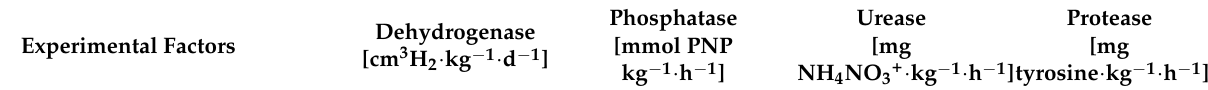
Table 9. Enzymatic activity of soil under cultivation of